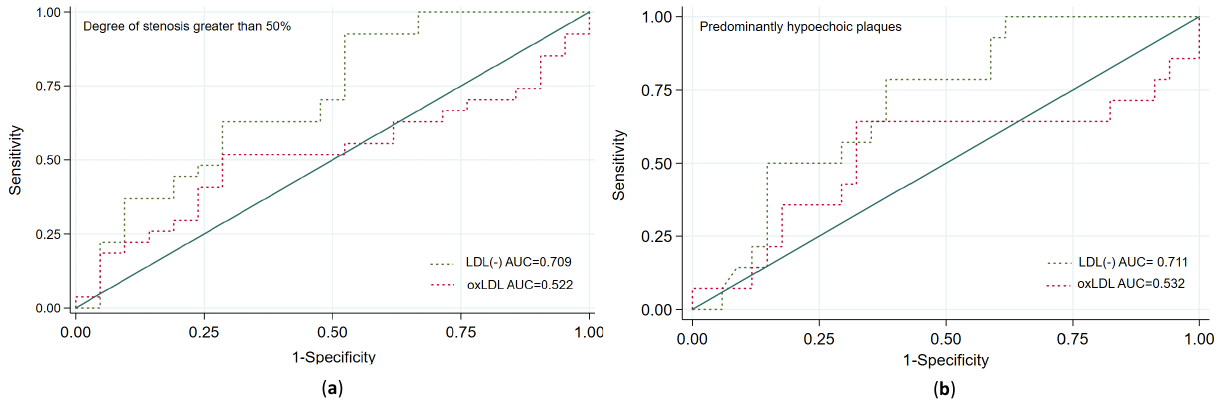
Figure 4. ROC comparison analyses between LDL( − ) and oxLDL. ( a ) Prediction of a carotid degree of stenosis greater than 50%. ( b ) Prediction of predominantly hypoechoic plaque.